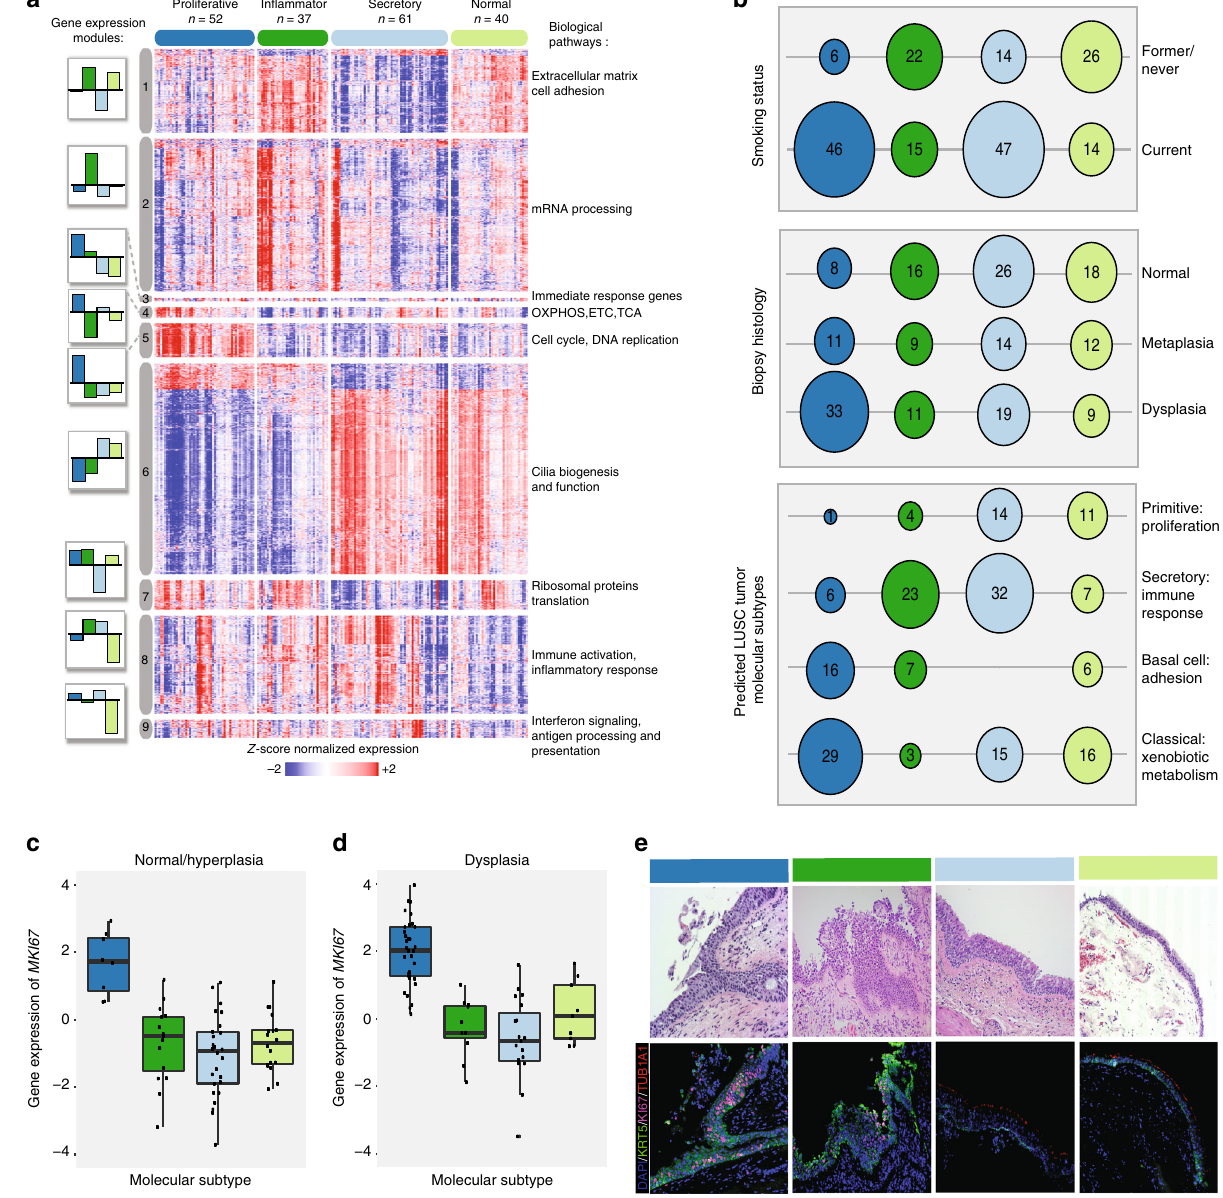
Fig. 1 Endobronchial biopsies divide into four distinct molecular subtypes that correlate with clinical and molecular phenotypes. a Genes ( n = 3936) organized into nine gene co-expression modules were used to discover four molecular subtypes (Proliferative, In fl ammatory, Secretory, and Normal-like) across the 190 DC biopsies using consensus clustering. The heatmap shows semi-supervised hierarchal clustering of z - score-normalized gene expression across the 3936 genes and 190 DC biopsies. The top color bar represents the four molecular subtypes: Proliferative ( n = 52 samples), In fl ammatory ( n = 37 samples), Secretory ( n = 61 samples), and Normal-like ( n = 40 samples). To the left of the heatmap, barplots for each module show the mean module GSVA score for each subtype. To the right of the heatmap, a summary of enriched biological pathways is listed for each module. b Bubbleplots showing signi fi cant associations ( p < 0.01, two-sided Fisher ’ s exact test) between the molecular subtypes and genomic smoking status, biopsy histological grade, and the predicted LUSC tumor molecular subtypes. The columns represent the four molecular subtypes (Proliferative, In fl ammatory, Secretory, and Normal-like) and the diameter of the circle is proportional to the number of samples within each subtype that have the row phenotype. c Boxplot of MKI67 expression values in biopsies with normal or hyperplasia histology ( n = 8, 16, 26, 18 in Proliferative, In fl ammatory, Secretory, and Normal-like subtypes, respectively). The MKI67 expression levels of the Proliferative subtype are signi fi cantly greater than non-Proliferative subtype samples (FDR = 3.4e-10, linear model). d Boxplot of expression values of MKI67 in biopsies with dysplastic histology ( n = 33, 11, 19, 9 in Proliferative, In fl ammatory, Secretory, and Normal-like subtypes, respectively). The MKI67 expression levels of the Proliferative subtype are signi fi cantly greater than non-Proliferative subtype samples (FDR = 3.1e-8). e Immuno fl uorescent staining demonstrating the increased MKI67 and KRT5 staining and reduced TUB1A1 staining in the Proliferative subtype. The representative samples shown for the Proliferative and In fl ammatory subtypes have dysplasia histology, whereas the samples shown for the Secretory and Normal-like subtypes have normal histology (Magni fi cation × 200). In the boxplots, the upper and lower hinges correspond to the fi rst and third quartile, center line represents the median, and whiskers extend from the hinge to the largest or smallest value at most 1.5 times the distance between the quartiles. Source data are provided as a Source Data fi